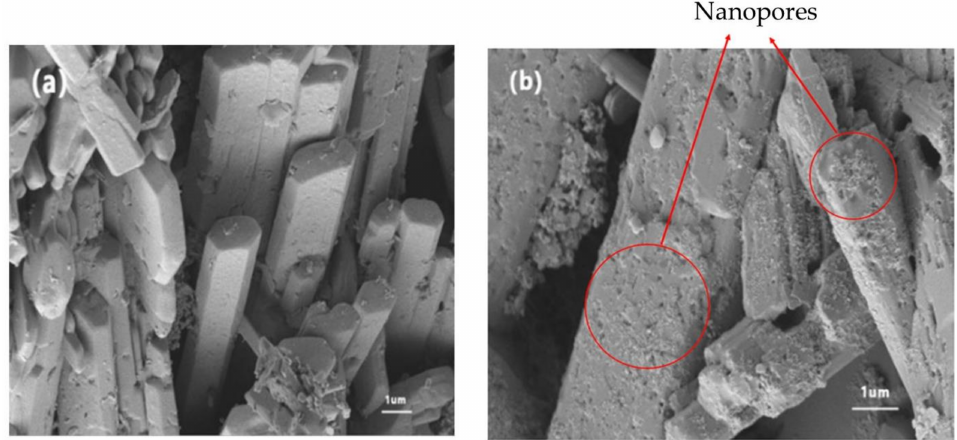
Figure 6. SEM image of phosphogypsum. ( a ) G 0 : blank group; ( b ) P 1 : modified